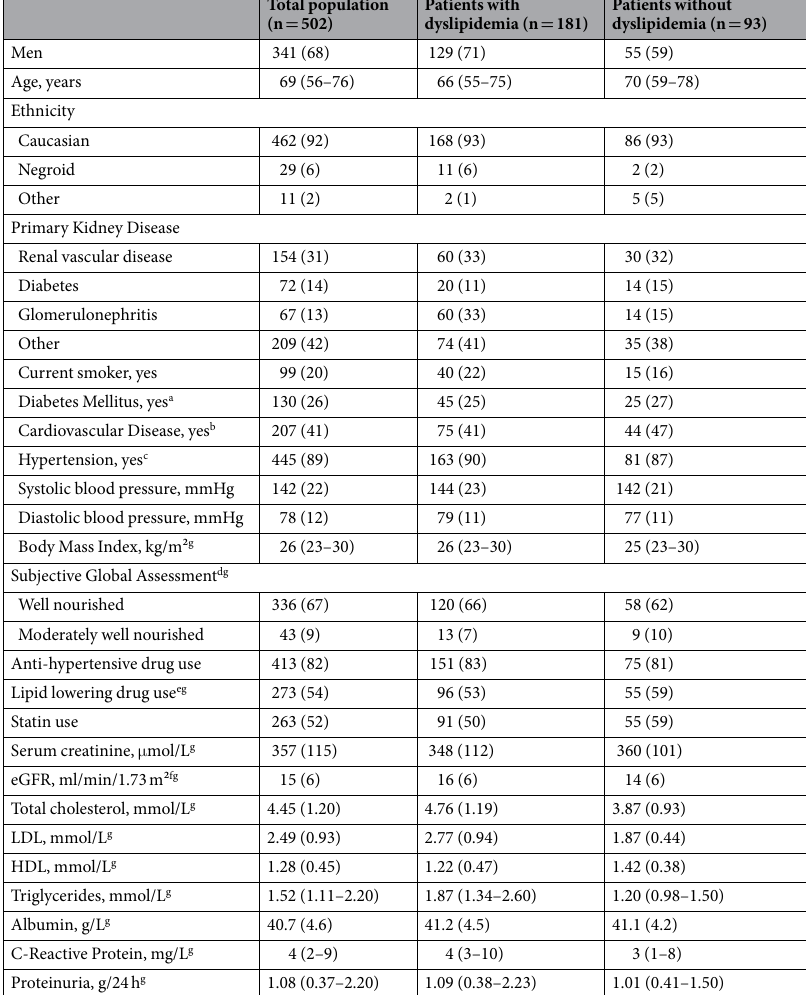
Table 1. Baseline characteristics of all 502 pre-dialysis patients of the PREPARE-2 Study and according to the presence of dyslipidemia. Values are given as mean ± SD or median and interquartile range (IQR). a Defined as the presence of diabetes mellitus as primary kidney disease or a history of diabetes mellitus. b Defined as presence of coronary artery disease, a history of cardiovascular accident, peripheral vascular disease, or myocardial infarction. c Defined as either a history of hypertension, antihypertensive drug use, a systolic blood pressure ≥ 140 mmHg or a diastolic blood pressure ≥ 90 mmHg at baseline. d Defined as well-nourished [subjective global assessment (SGA) 6–7], moderately well-nourished (SGA 3–5), and severely malnourished (SGA 1–2). e Defined as the prescription of statins, fibrates, or cholesterol absorption inhibitors. f eGFR (estimated glomerular filtration rate) is calculated with the CKD EPI (Chronic Kidney Disease Epidemiology Collaboration) formula 2009. g Body Mass Index was known for 492 patients, Subjective Global Assessment for 379, Serum creatinine and eGFR for 438, proteinuria for 247, total cholesterol for 230, LDL cholesterol for 201, HDL cholesterol for 207, triglycerides for 211, albumin for 403, C-reactive protein for 198, and lipid lowering drug use for 398